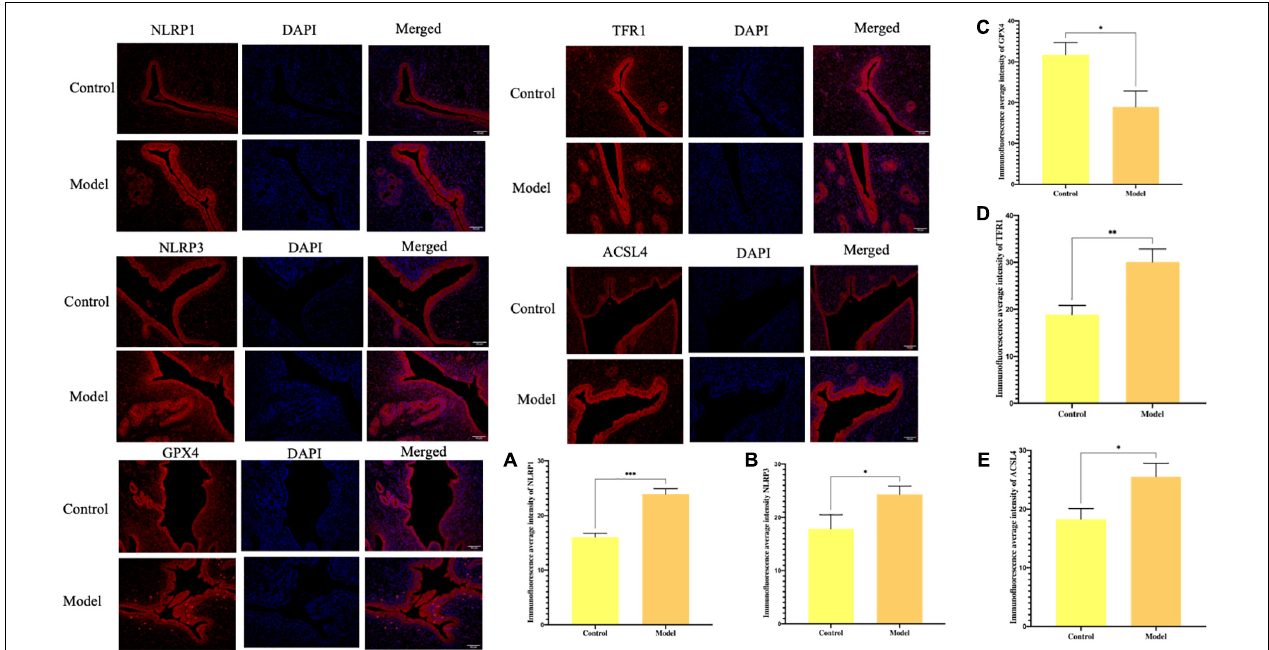
FIGURE 1 | Immunofluorescence for the protein expression and % area for the immunohistochemical staining intensity in uterus tissue in rats. (A) The expression of NLRP1. (B) The expression of NLRP3. (C) The expression of GPX4. (D) The expression of TFR1. (E) The expression of ACSL4 (* P < 0.05, ** P < 0.01, and *** P <